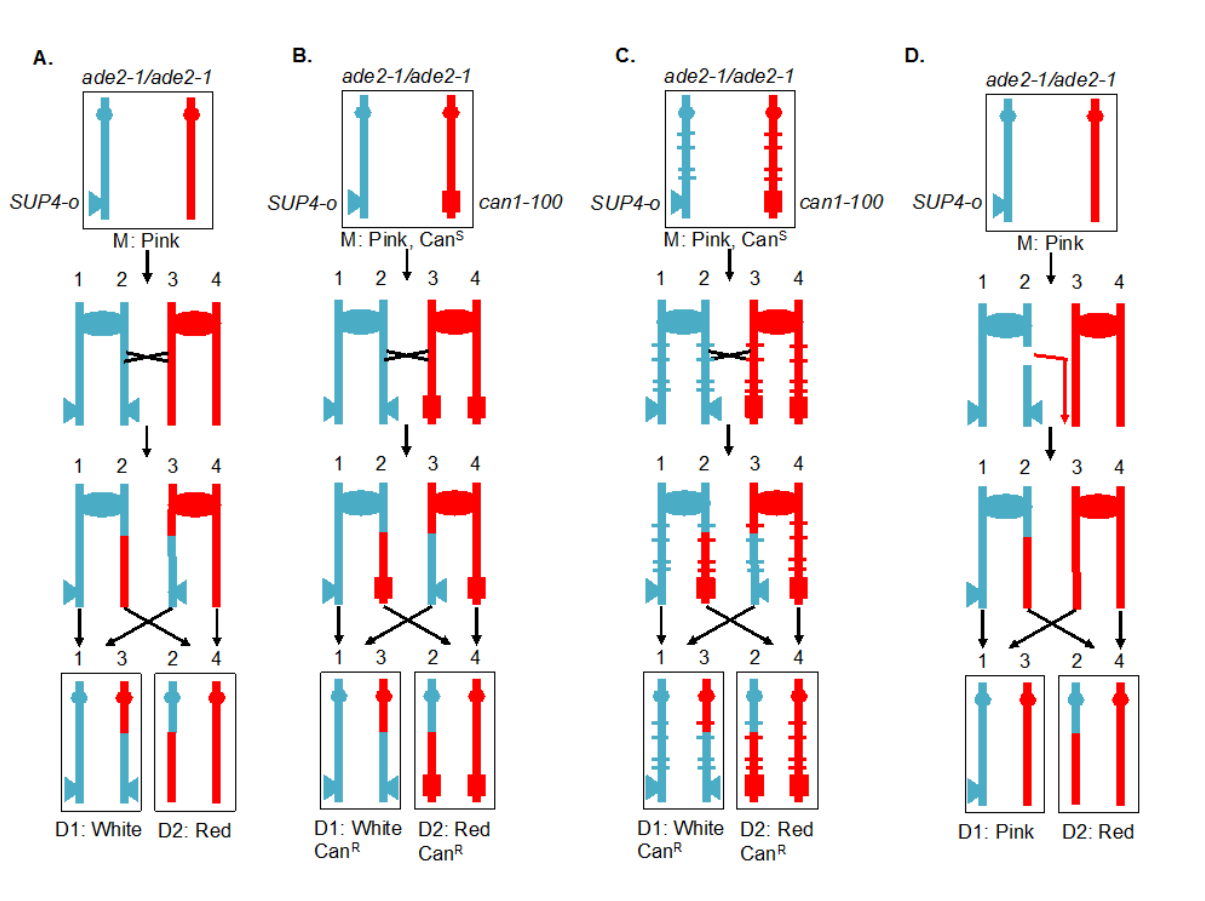
FIGURE 4 : Recombination between homologous chromosomes during mitosis. Sectoring assay for monitoring mitotic crossover in the interval between the centromere (oval) and the SUP4-o insertion (triangle). Blue and red indicate the two homologs in the diploid cell. In this version of the assay, the markers are located on the left arm of chromosome V. (A) System for screening mitotic crossover by red/white sectoring assay. (B) Selection system of reciprocal crossovers. (C) Hybrid diploid strains with selection system for recovering reciprocal daughter cells after a crossover event, and with sequence polymorphisms (marked by blue and red ticks) for mapping positions of crossovers. (D) Detection of a non-reciprocal recombination event by a sectoring assay. In the diagram, a DSB on the chromosome containing the SUP4-o gene is repaired by a break-induced replication (BIR) event using the other homolog. The centromere-distal frag- ment containing the SUP4-o gene is lost, resulting in a pink/red sectored OPEN ACCESS | www.microbialcell.com